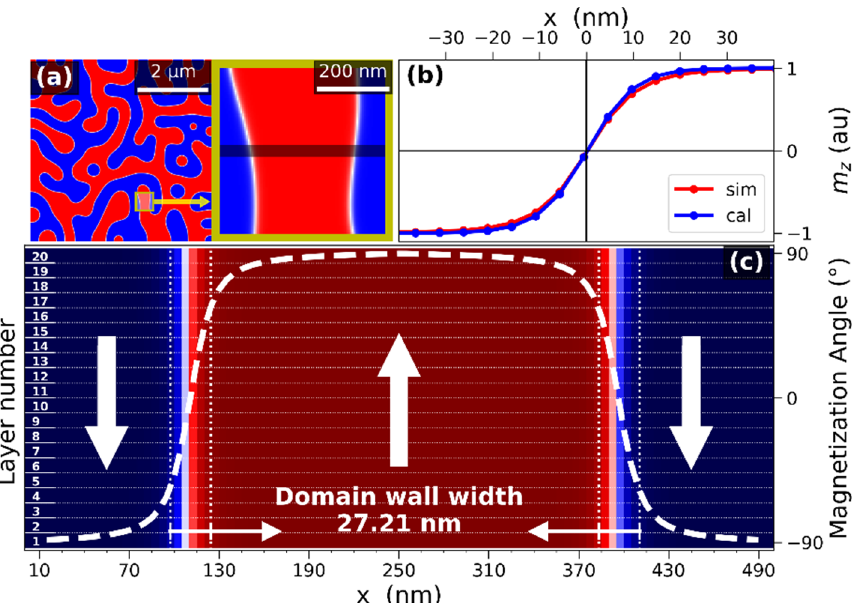
Figure 3. Results of the MuMax3 micromagnetic simulations of the Ti/Pt/Co sample: The relaxed magnetization pattern averaged over the stack thickness together with a zoomed in view ( a ). Per- pendicular magnetization component of the top layer in a transition between two domains together with a calculated transition using the standard Bloch wall model ( b ). Cross section of a cutout of the magnetization of the Ti/Pt/Co sample showing all 20 layers ( c ). The magnetization in the domains is homogeneous and independent of the layer number. The overall magnetization of the domains is depicted by the arrows. The dashed line shows the angle of the magnetization that follows a Bloch-like course of the domain wall transition. The dotted lines mark the domain wall width calculated using the Lilley formula.